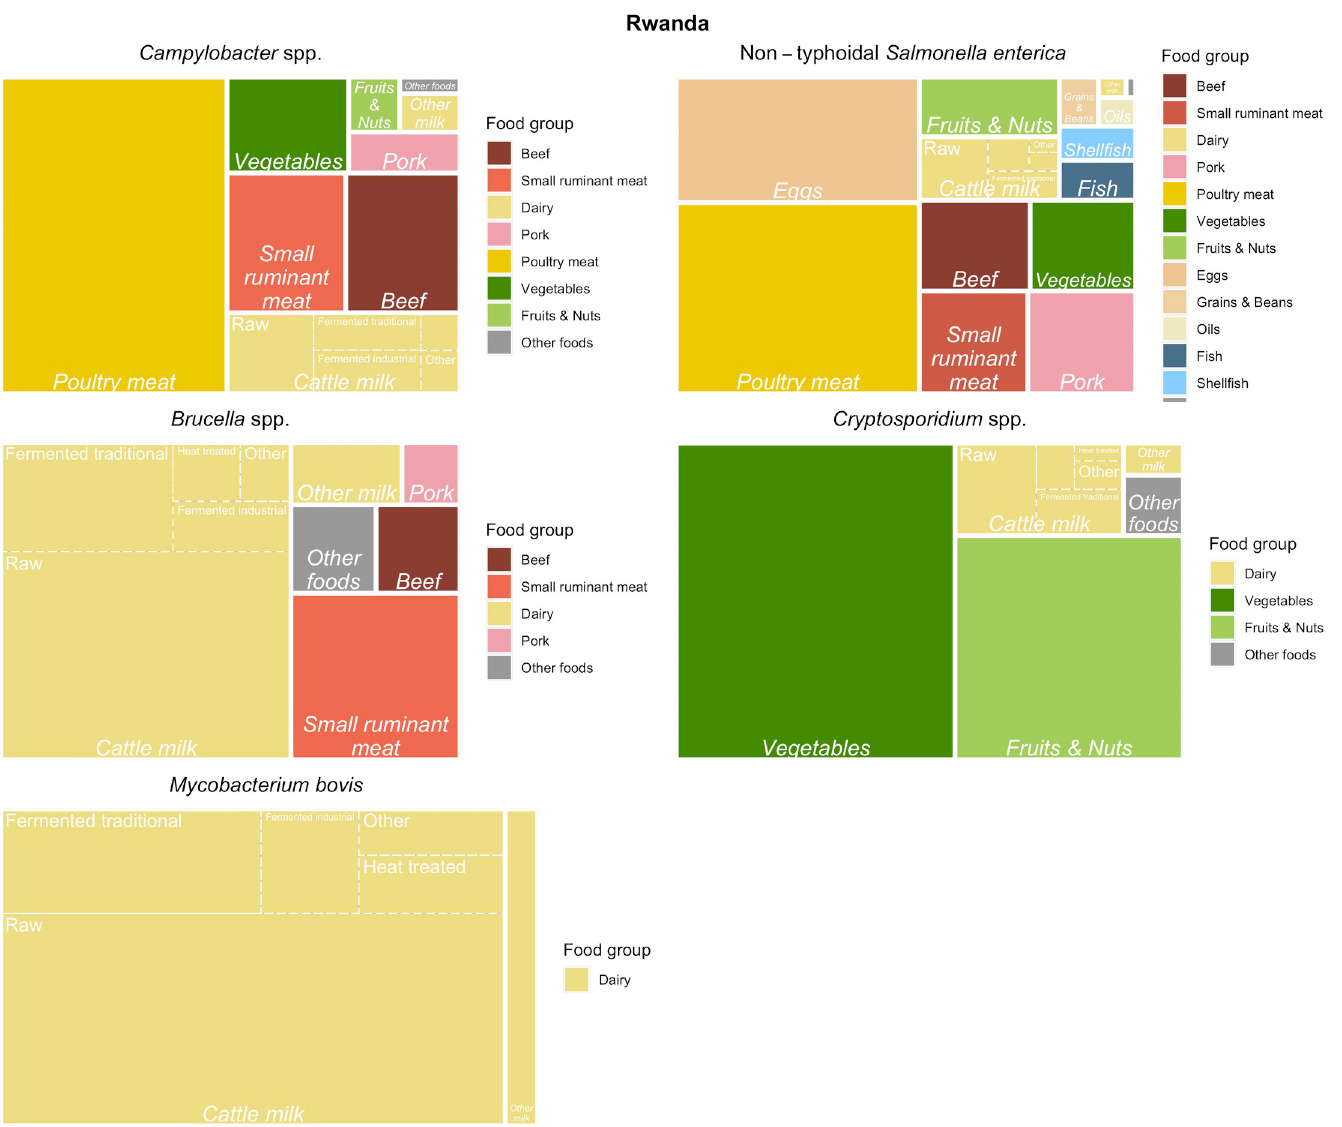
Fig 7. Treemaps of mean estimates of the proportion of illnesses caused by Campylobacter spp., non-typhoidal Salmonella enterica , Brucella spp., Cryptosporidium spp. and Mycobacterium bovis through food group/type/product exposure pathways for Rwanda.